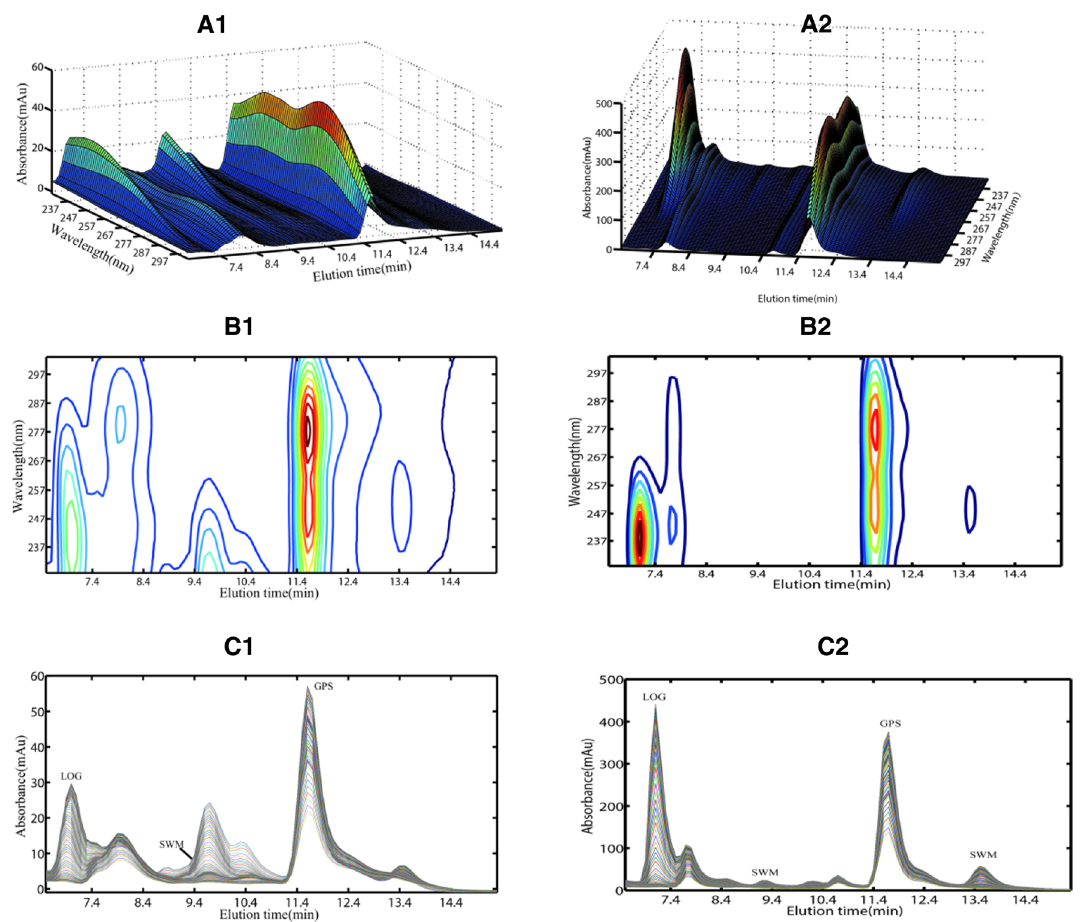
Fig. 2 Three-dimensional plot of a typical chromatogram of urine ( a1 ) and feces samples ( a2 ) from rat administered with low dosage of Radix Gentianae Macrophyllae water decoction (16 g kg - 1 ) within